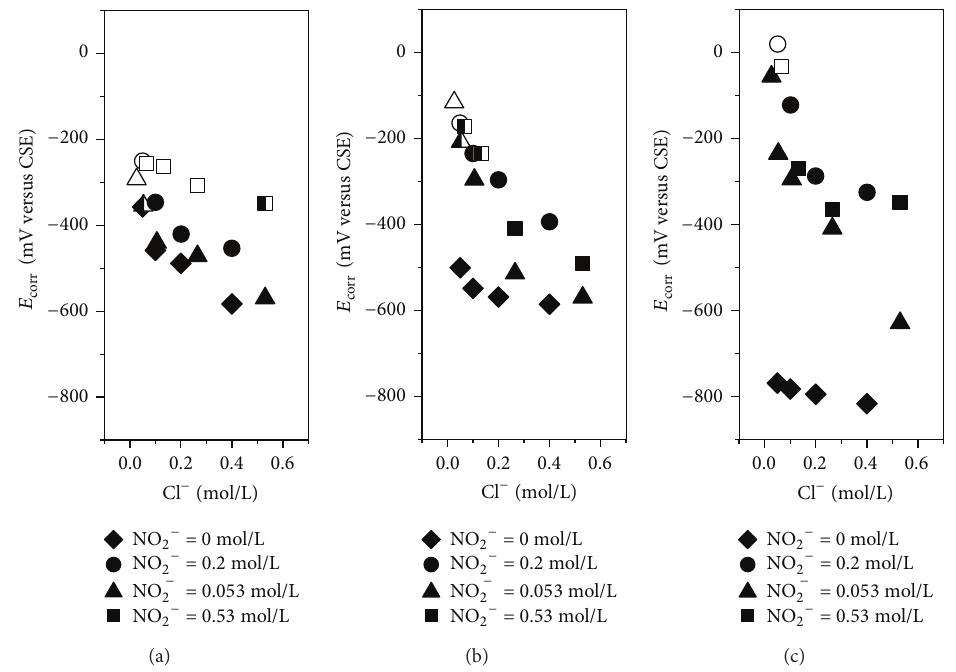
Figure 4: Effect of NO 2− and pH on 𝐸